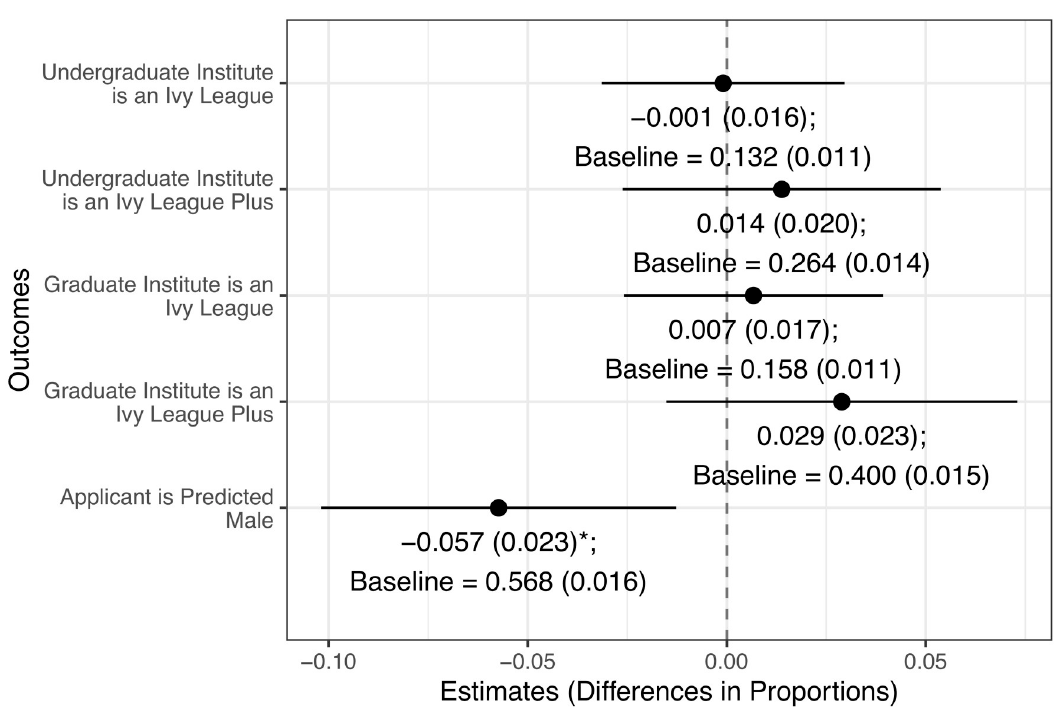
Fig 1. Comparing differences in background characteristics between winners and non-winners. N = 2, 119. We find a slight imbalance between treated and control groups only in predicted gender; however, the groups are balanced on the quality of undergraduate university and quality of graduate